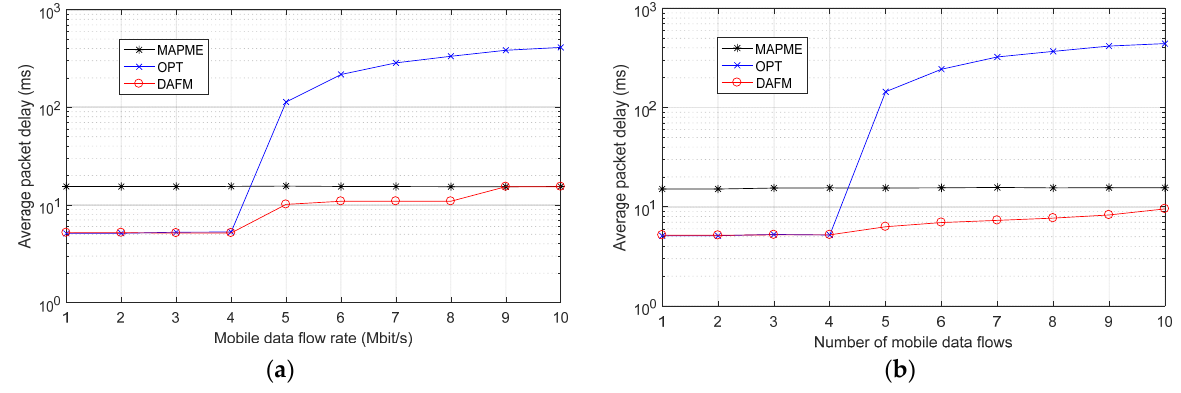
Figure 4. Comparison of average packet delays in different scenarios. ( a ) Average packet delay vs. mobile data flow rate; ( b ) average packet delay vs. number of mobile data flows.